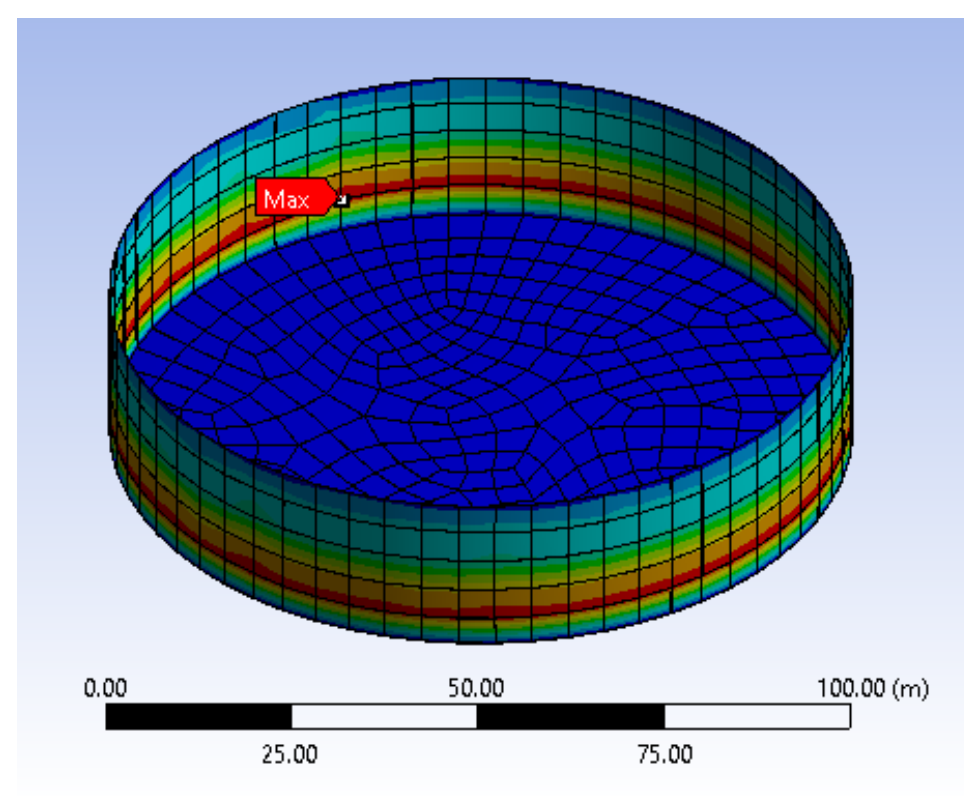
Figure 4. Location of maximum deformation of the tank.